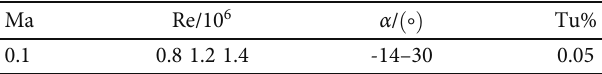
Table 1: Freestream